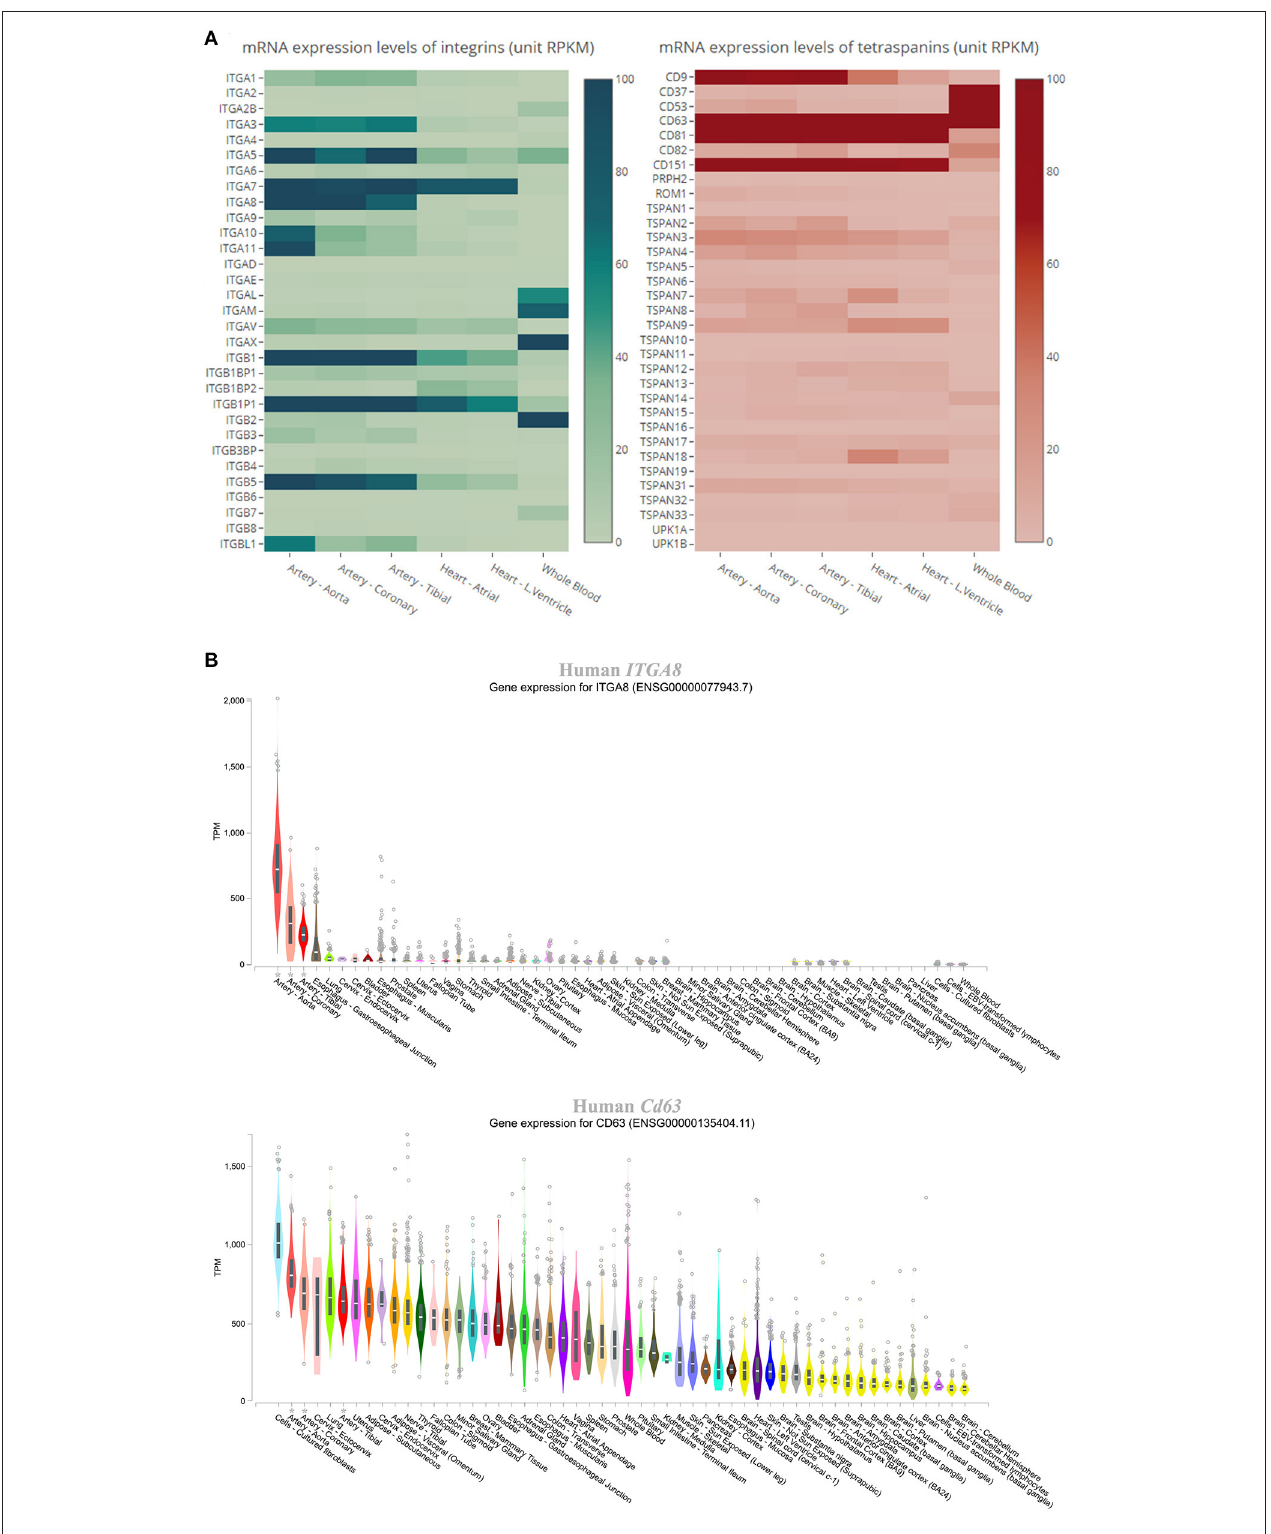
FIGURE 2 | Expression levels of integrins and tetraspanins in human cardiovascular tissues. (A) Heatmaps showing the mRNA levels in the units of RPKM (reads per kilobase of transcript, per million mapped reads) of the integrins and tetraspanins in human aorta, coronary artery, tibial artery, heart atrium, left ventricle, and whole blood. (B) Box plot showing the expression levels, presented as TPM (transcripts per kilobase million), of ITGA8 and Cd63 across various human tissues. All data were extracted from GTEx.